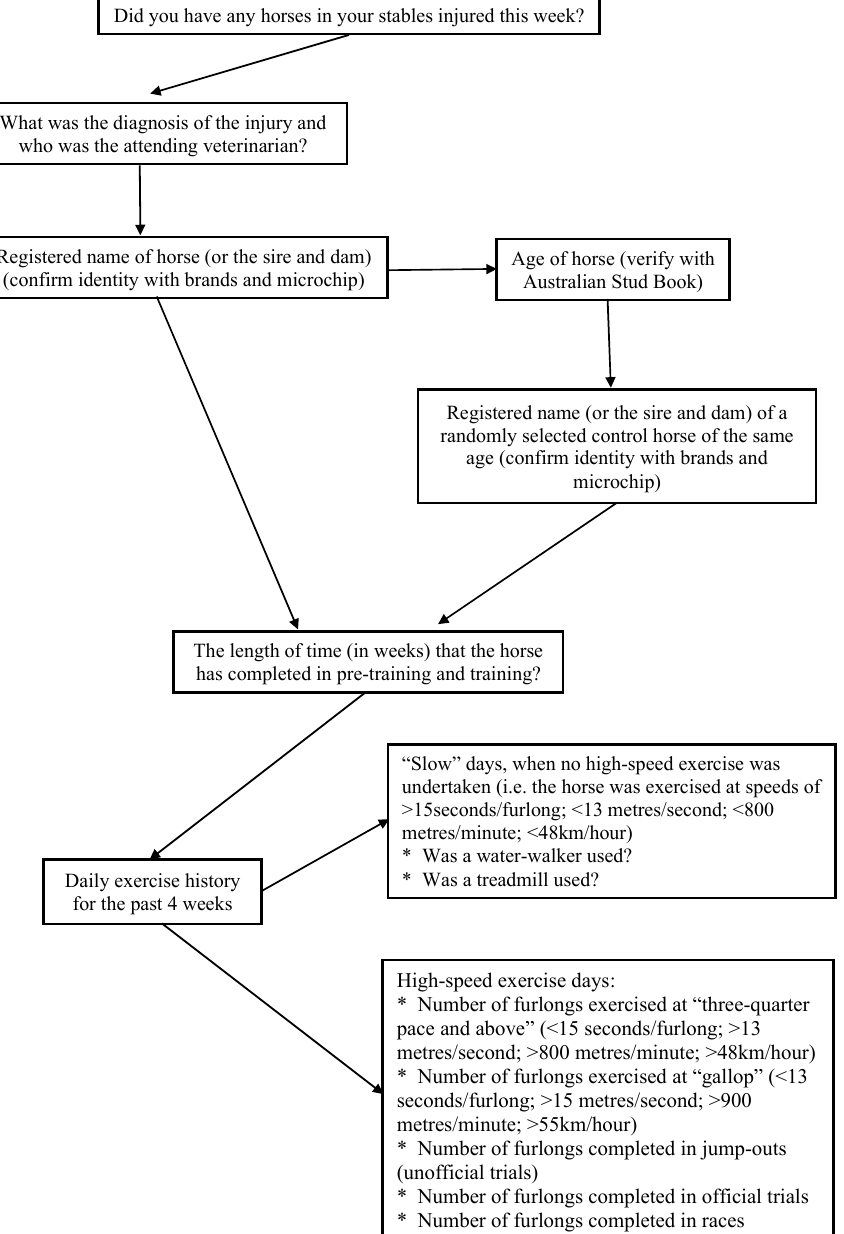
Figure A2. The personal structured interview used to investigate risk factors for MSI in Thoroughbred racehorses in South-East Queensland, Australia.